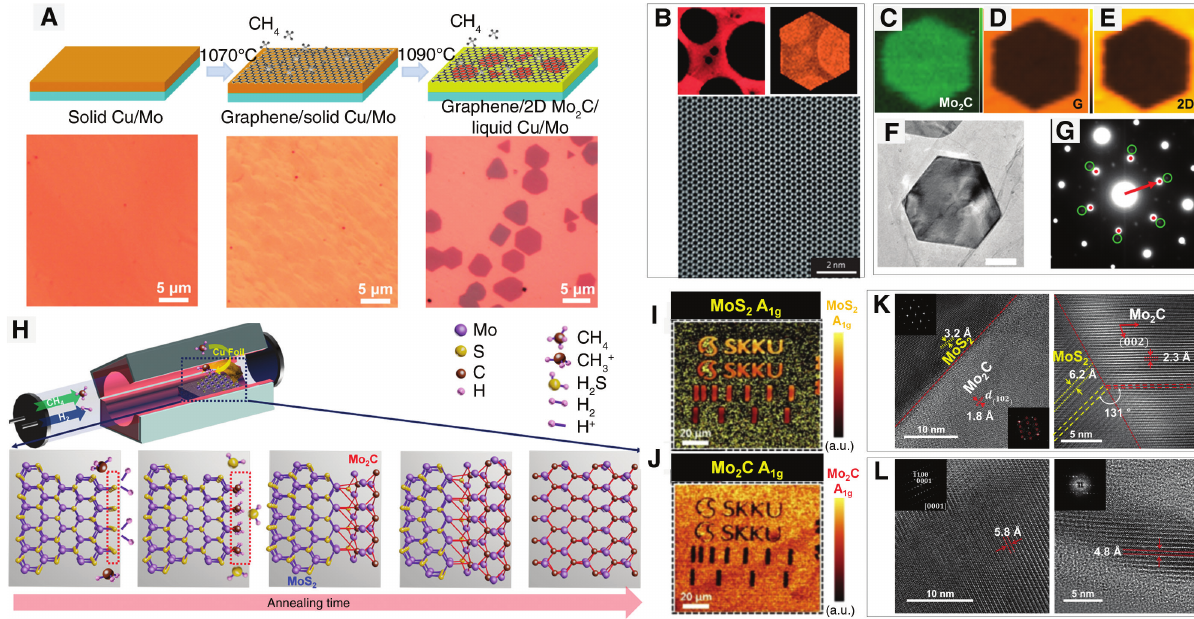
Figure 3: CVD methods for the synthesis of MXenes and MXene heterostructures. (A) Schematic illustration of CVD growth of 2D Mo and CH environment. Optical images were obtained at each step. The single 2D α -Mo 4 1085 ° C, and Gr/Mo C heterostructure was achieved by two-step growth. First, Gr was formed at 1070 ° C, and subsequently Mo 2